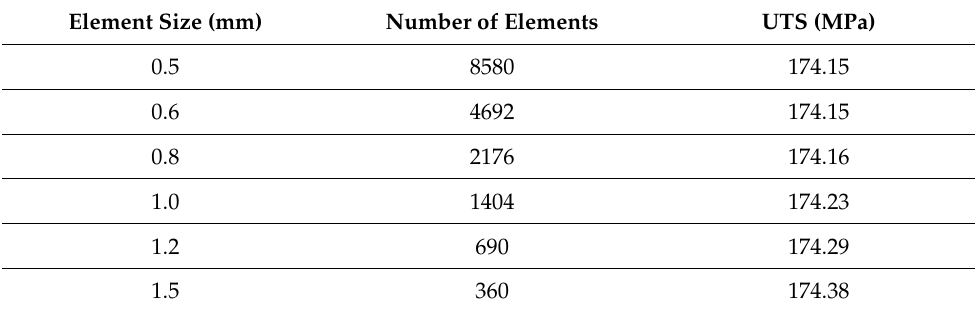
Table 1. Mesh sensitivity analysis of tensile simulation in ST condition.